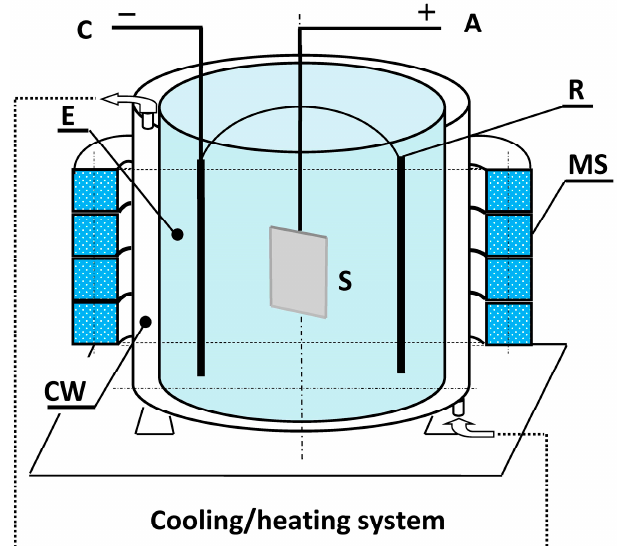
Figure 1. Electropolishing electrolytic cell with superimposed magnetic field: A—anode, C—cathode, MS—stack of ring magnets, CW—cooling water, E—electrolyte, R—aluminum rod, S—niobium